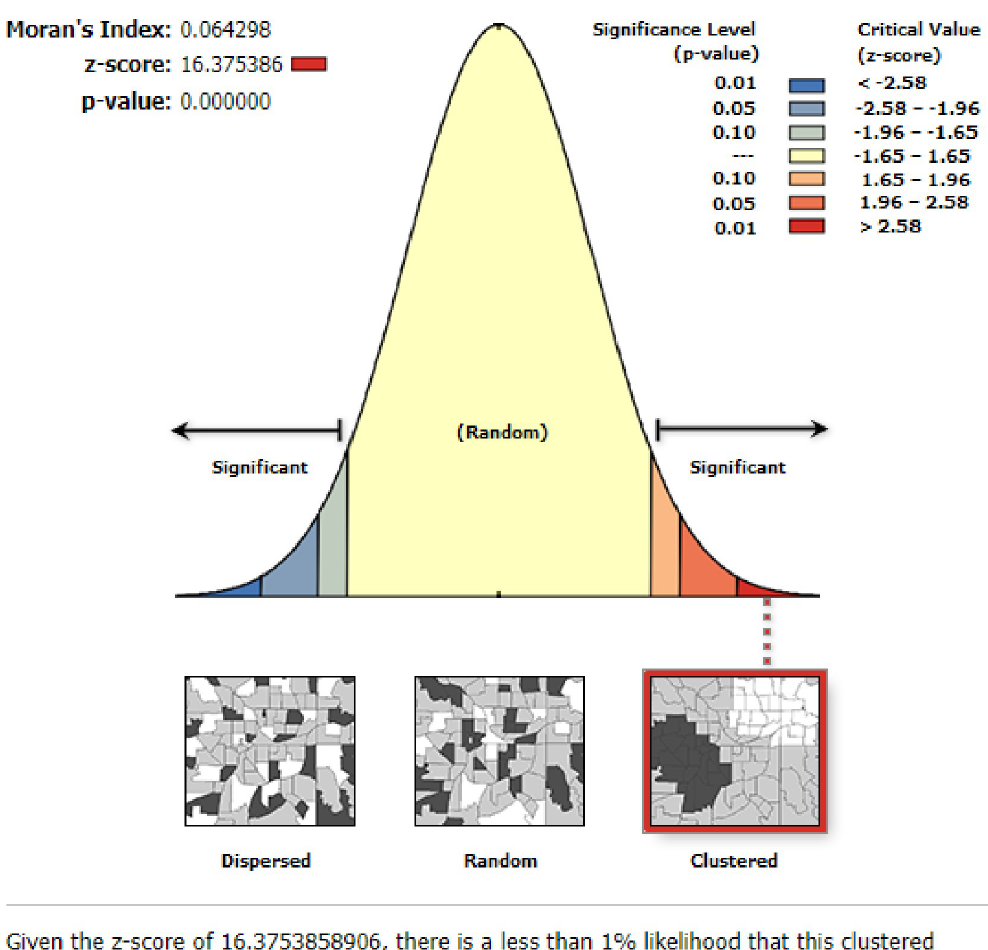
Fig 2. Spatial autocorrelation analysis of women unemployment status in Ethiopia, 2016